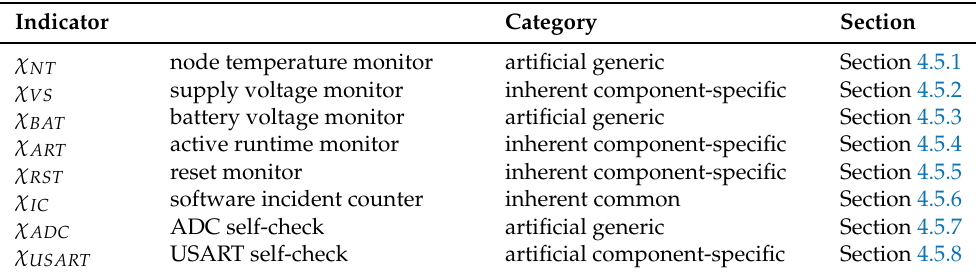
Table 2. Overview of the current ASN(x) fault